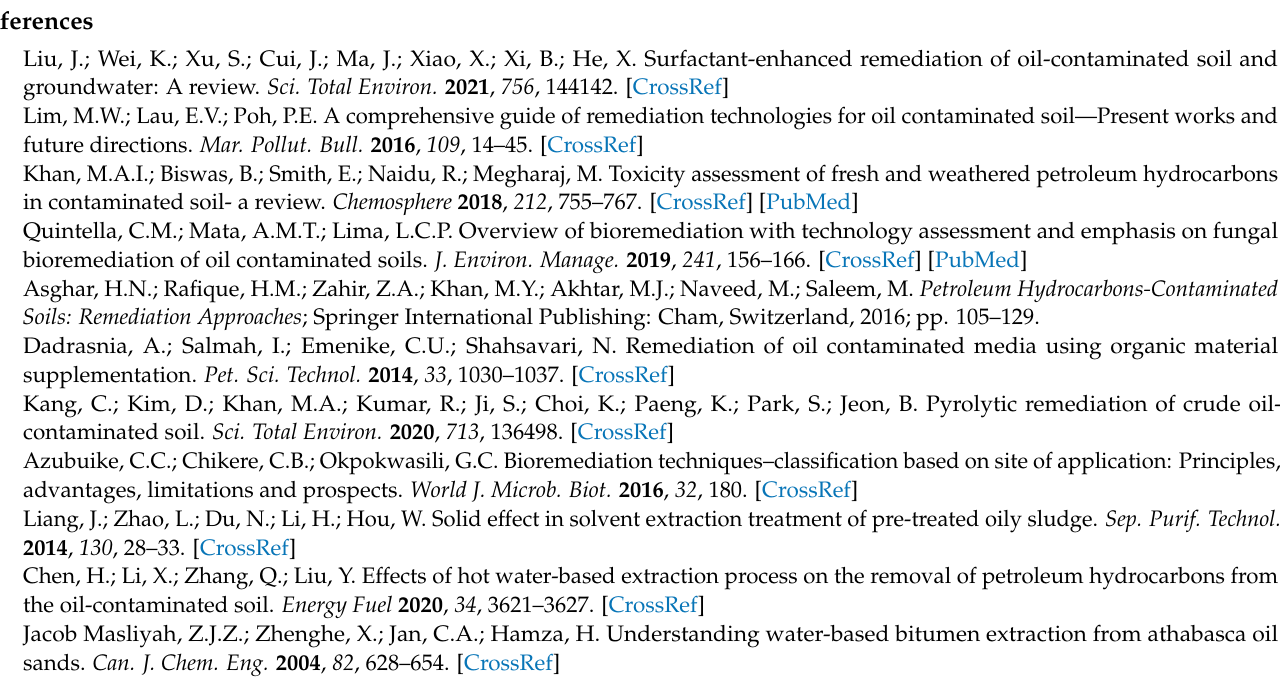
10.3390/molecules27227950/s1, Figure S1: Schematic of the experimental setup for measuring the interfacial modulus; Figure S2: The adsorption isotherms of (a) Mnt and (b) Kln at 293, 303, and 313 K; Figure S3: SEM images of (a) Mnt and (b) Kln; Figure S4: Sedimentation tests of suspensions with different concentration ratios of clays; Table S1: Structural parameters of different systems at 298 K; Table S2: Force values of the two clays interacting with oil droplets at 298